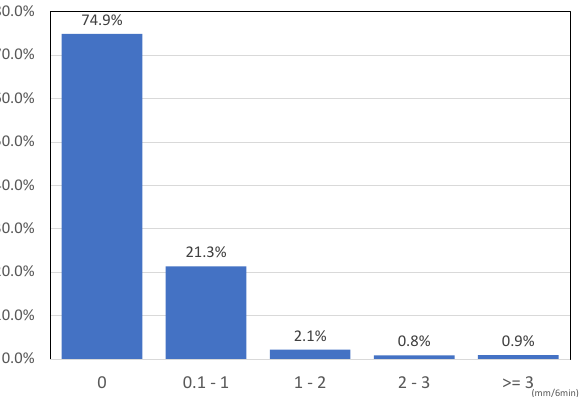
Figure 6. The occurrence frequencies of different rainfall intensity in our dataset, in Anhui province of China, from April to October from 2016 to 2018 (except October in